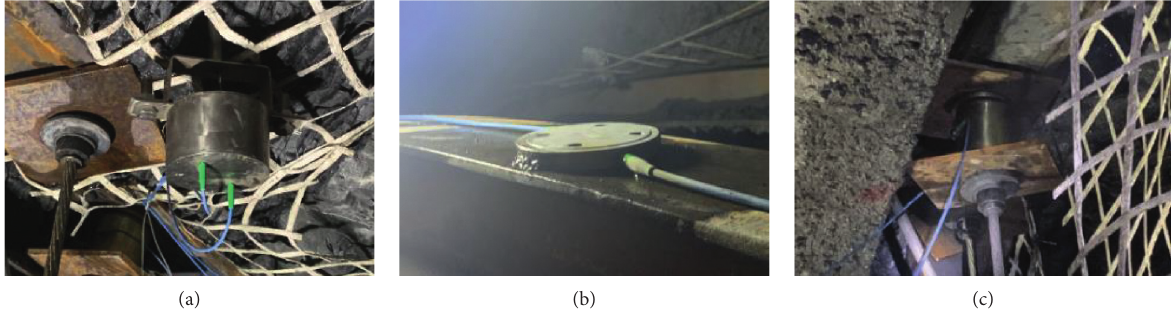
Figure 19: Field monitoring instruments. (a) Deep displacement meter. (b) Stress gauge. (c) Axial force gauge.